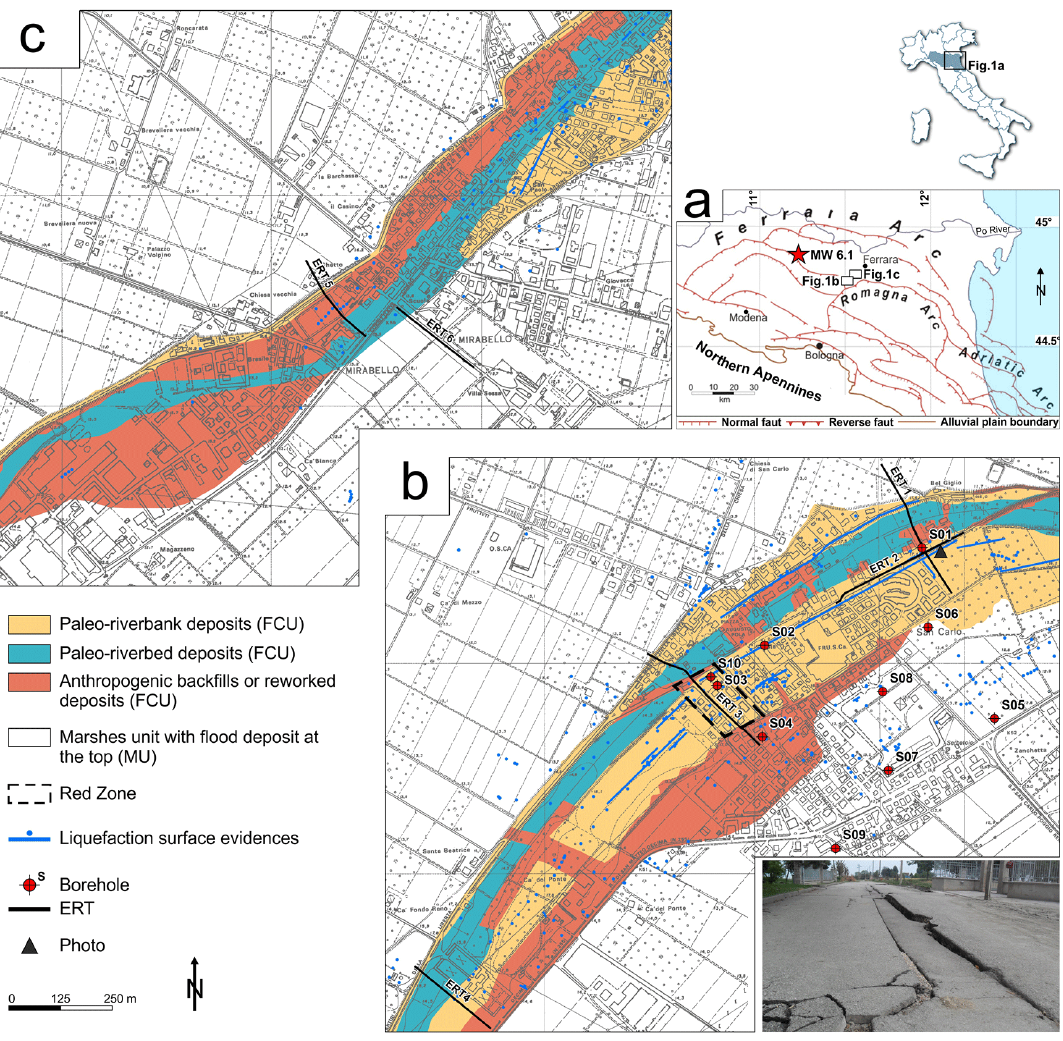
Fig. 1. (a) Simplified tectonic map showing the epicenter of the 20 May 2012 Emilia-Romagna earthquake (modified from CNR-PFG, 1991). Sketch map of the surface deposits derived from digital elevation models, field observations and boreholes. (b) San Carlo. Black triangle is the location of photo. (c)